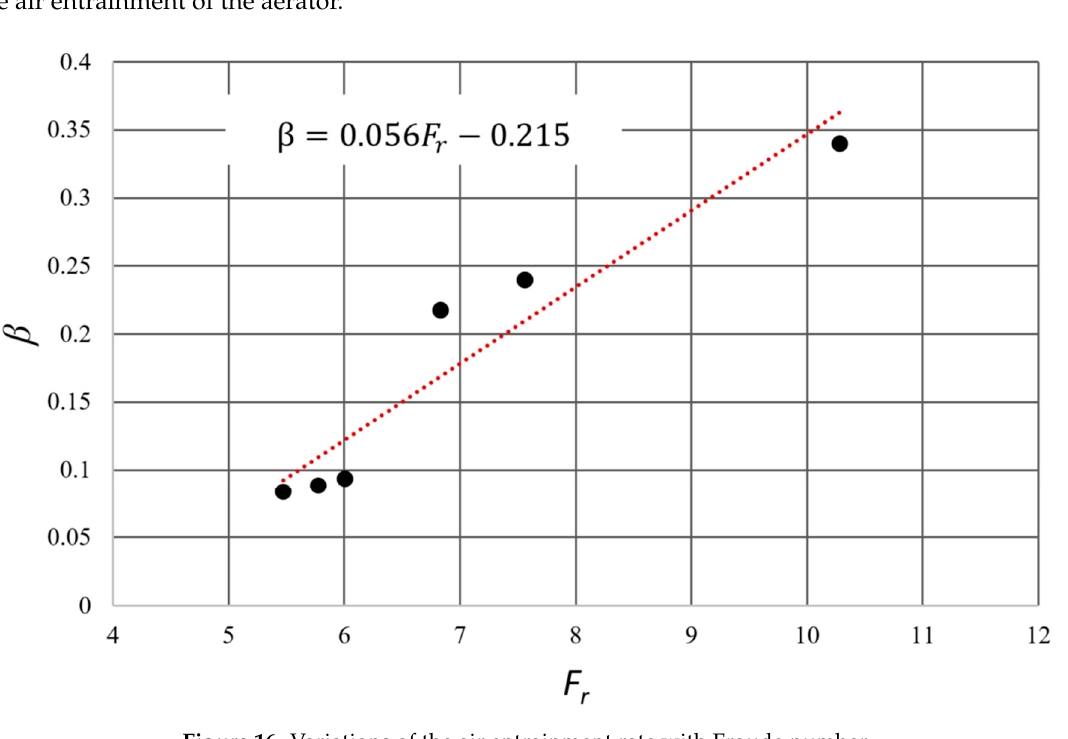
Figure 16. Variations of the air entrainment rate with Froude